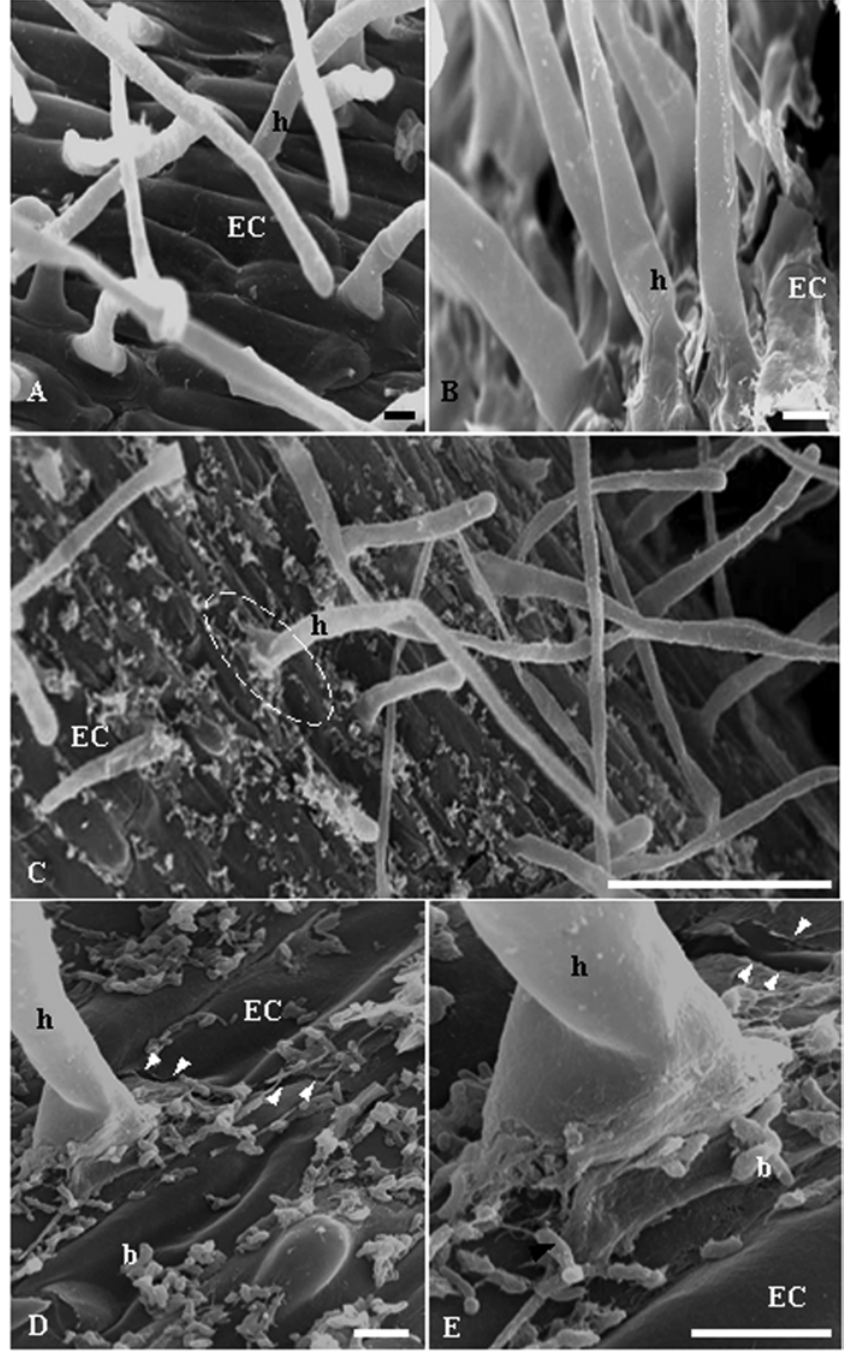
Fig. 1 – SEM of rice root colonization (root hair zones) by B. kururiensis at 7 dpi. SEM from roots of uninfected control plantlet under gnotobiotic conditions ( A, B ). Note that no bacteria are present on the root hair ( A ) or their bases ( B ). In ( C ) is the general view of the root surface covered with bacteria. The pointed ellipse shows area around the hair base where invasion may occur. ( D ) Zoomed view of the area inside the ellipse showing the destruction bacterial clusters frequently present on the hair base, and their adhesion onto the rhizoplane, possibly representing a focused attack to the root epidermis (arrowheads), best visualized under high magnification ( E ). EC , epidermal cells; h , root hair; b , bacteria. Bar = 1 μ